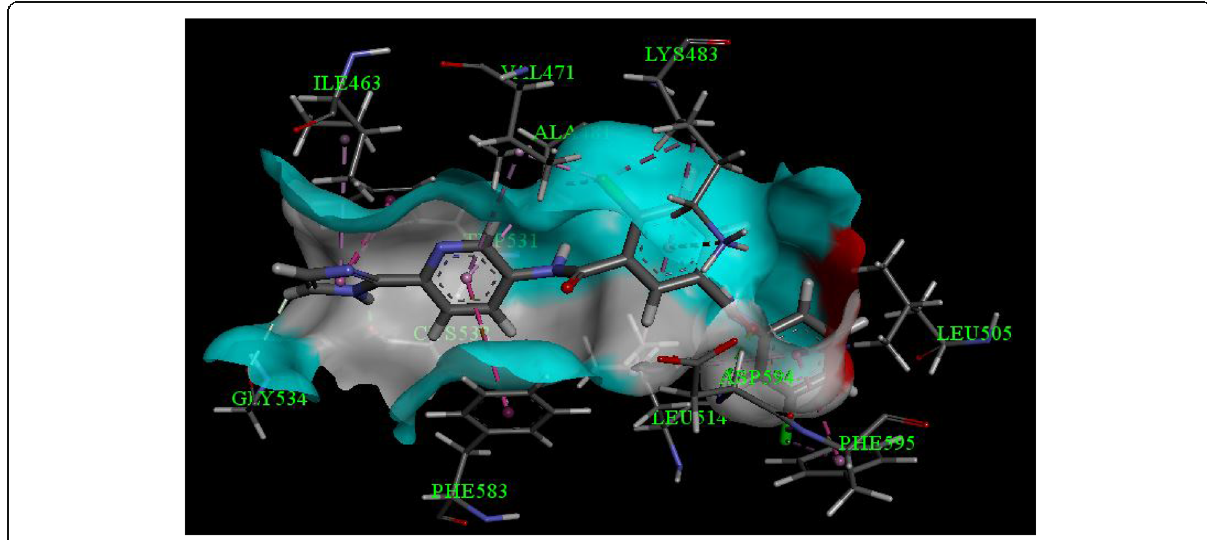
Fig. 4 3D diagram for the interaction of compound 30 with V600E-BRAF